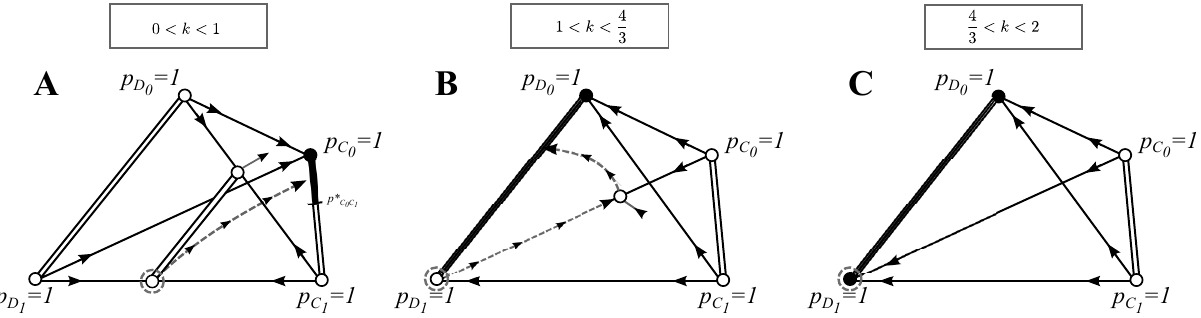
Figure 1. Phase plane analysis for the basic model: Each panel presents a simplex where each point is a frequency distribution at some point in time with double-lines, we indicate the set of frequencies where each point is an equilibrium; with black color, we show which equilibrium is stable (not necessarily asymptotically stable) and with white color, which equilibria are unstable. Arrows indicate the direction of the dynamics along each eigenvector. Grey dashed arrows give an example of an invasion-substitution sequence. See Section 3.1 for the discussion of the evolutionary properties of this model and the Appendix for the full analytical